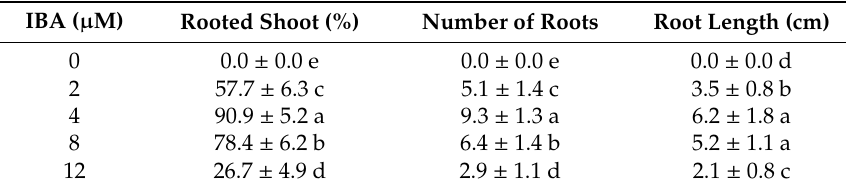
Table 6. E ff ect of IBA on in vitro rooting of Catharanthus roseus .